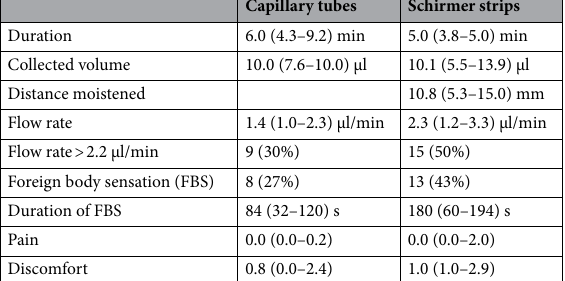
eye variability, results from both eyes were compared (Table 2). In a comparison of data from the eye sampled as first (side I) and as second (side II), no significant differences were observed when samples were gathered with capillary tubes. For samples collected with Schirmer strips the tear flow rate was significantly lower for the collection on side II ( p = 0.008) while protein and IgG concentrations were significantly higher ( p = 0.01 and p = 0.02).